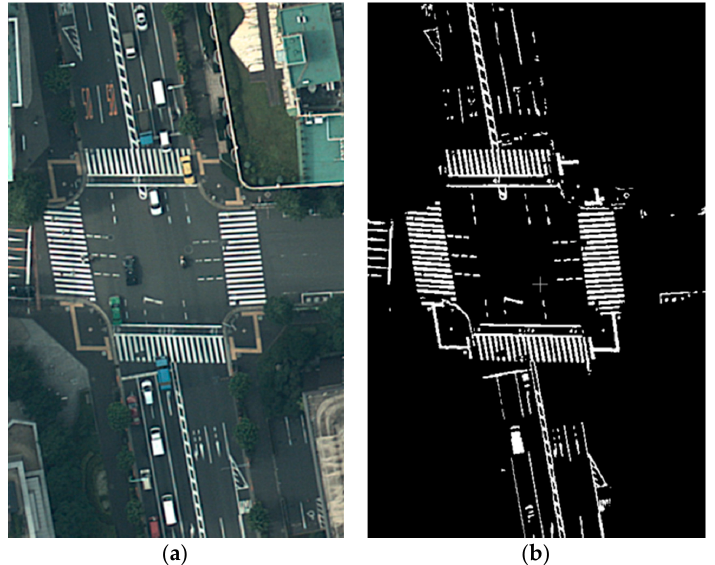
Figure 7. Road marking extraction from an aerial image by adaptive thresholding: ( a ) a part of the original aerial image; and ( b ) result of the road marking extraction process.